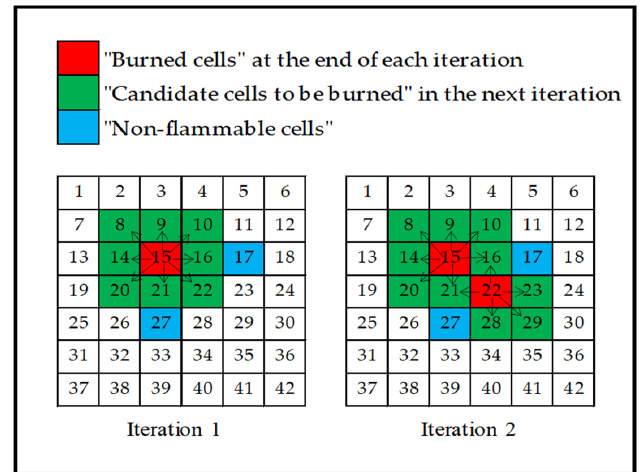
Figure A2. An example to illustrate the preprocessing algorithm. In this example, a rectangular landscape including 42 cells is used to examine fire ‐ spread ‐ pattern for the first two iterations, assuming “stop” criteria are not met yet. The number in each cell represents the cell’s ID. There are two non ‐ flammable cells (i.e., open water represented by the two blue cells 17 and 27) and 40 flammable cells (i.e., forest). The arrows represent all possible fire spread paths to the “candidate cells to be burned” (green) in the next iteration. In this ex ‐ ample, cell 15 is assumed to be the fire’s ignition cell, which is the cell burned earliest at the end of iteration one. At iteration two, fire can spread from cell 15 to its eight “candidate cells to be burned” (8, 9, 10, 14, 16, 20, 21, and 22). The fire is assumed to spread from cell 15 to cell 22 faster than spreading to the other seven cells. Under this assumption, cell 22 would be identified as the cell burned earliest at the end of the second iteration.